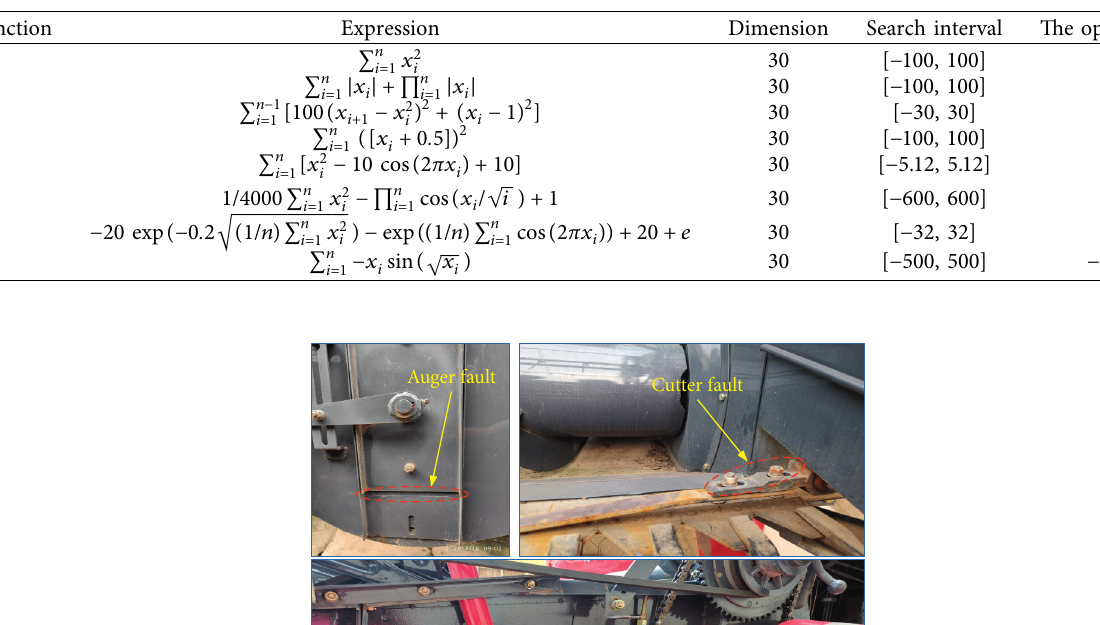
Table 2: Benchmark function.